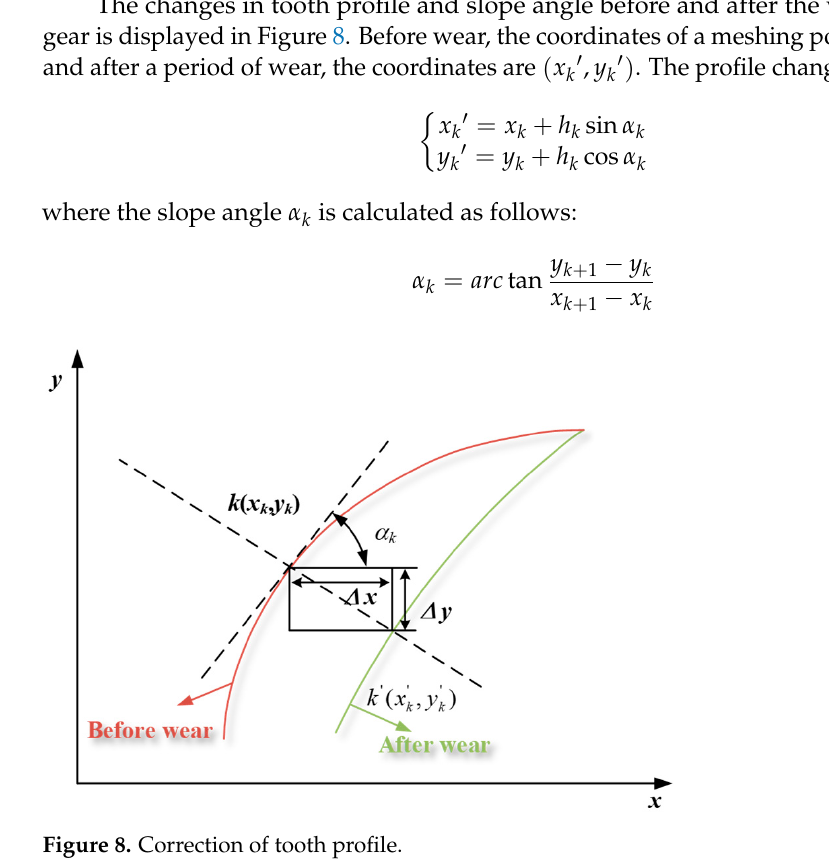
Figure 8. Correction of tooth profile.